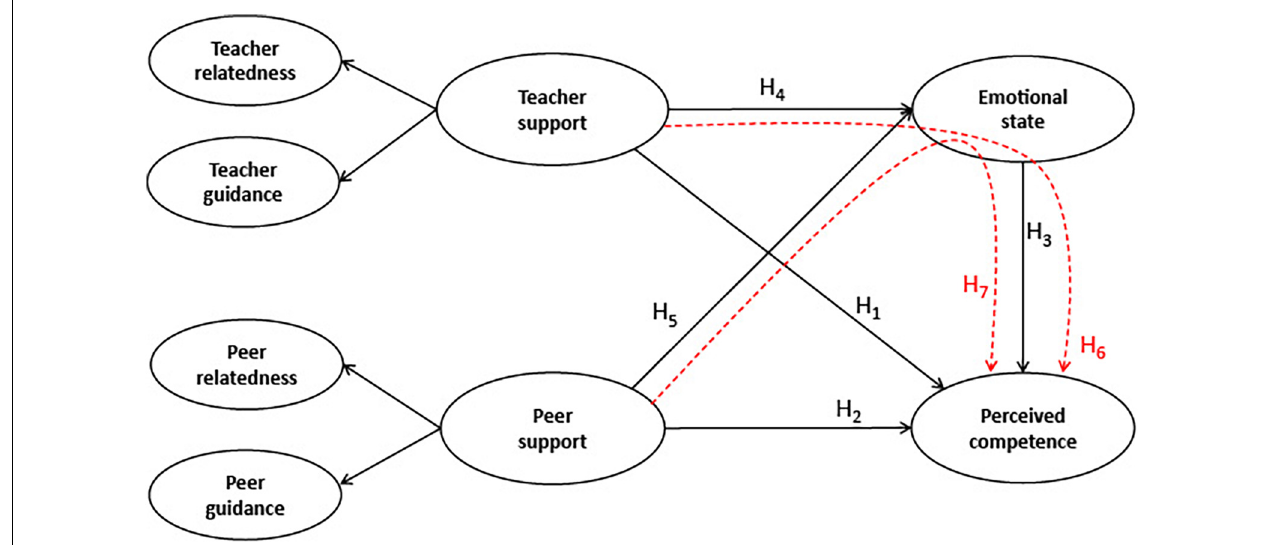
FIGURE 1 | Representation of the hypotheses (H 1 -H 7 ); direct relationships represented in black, indirect in